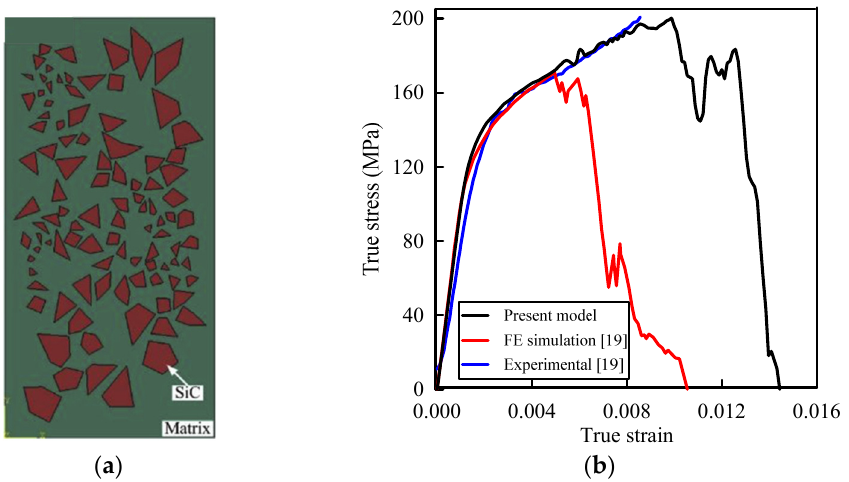
Figure 3. ( a ) Microstructure of A359/SiC composite (adapted with permission from ref. [19], Copy- right 2016 Springer); ( b ) True stress–strain curves of A359/SiC